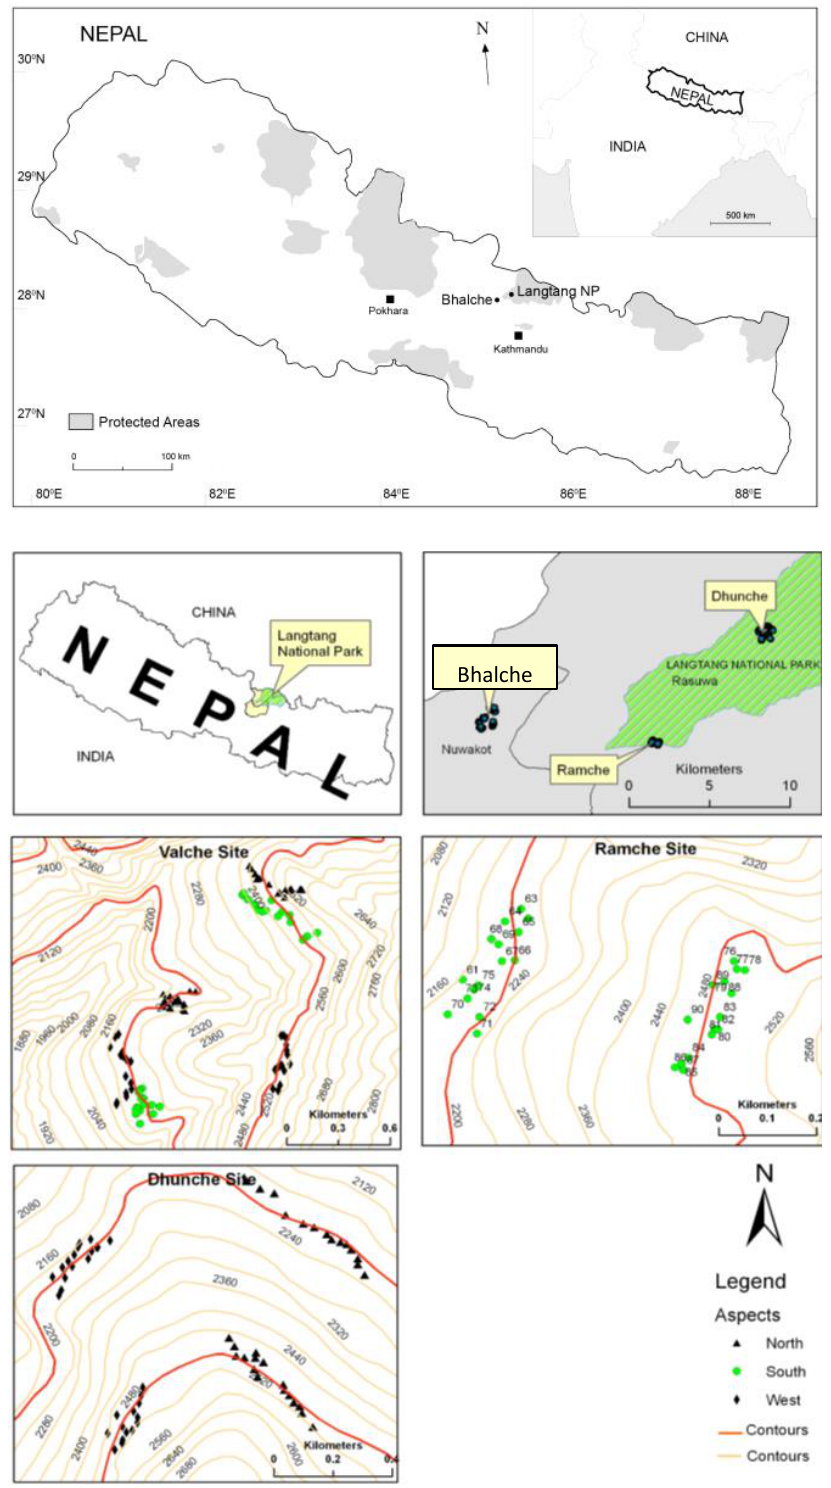
Figure 1. The study areas in Langtang National Park (Rasuwa district: Ramche and Dhunche) and at Bhalche (Nuwakot district) ( bottom ). Both sites are part of the Trisuli watershed in the Langtang area of Nepal ( top